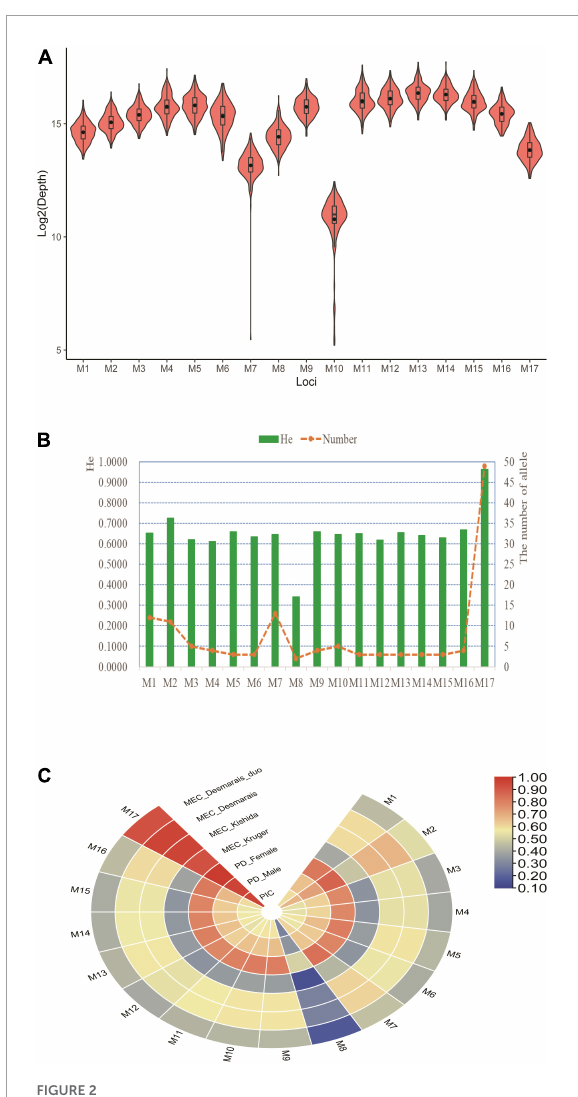
FIGURE2 Depths of coverage (A) , expected heterozygosities (B) , and forensic parameters (C) of 17 X-chromosomal Multi-InDels in the studied Guizhou Han